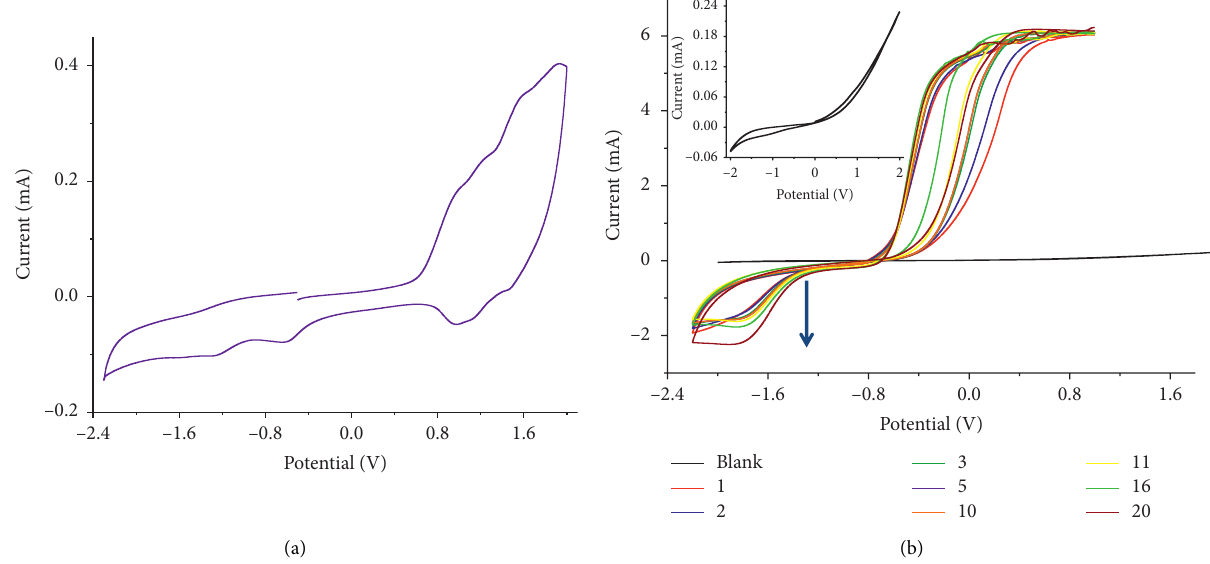
Figure 2: (a) Cyclic voltammogram of complex 1 in DCM containing 0.1mol · dm − 3 TBABF ∼ 1 × 10 − 4 mol · dm − 3 , and electrode � glassy carbon. (b) Evolution of the cyclic voltammograms of complex 2 in DCM containing 0.1mol · dm − 3 TBABF 4 during repeated successive scans (only 8 scans are shown), scan rate � 100mV/s, concentration ∼ 1 × 10 − 4 mol · dm − 3 , and electrode � Al coupon. Inserted is the cyclic voltammogram of blank (without complex 2).